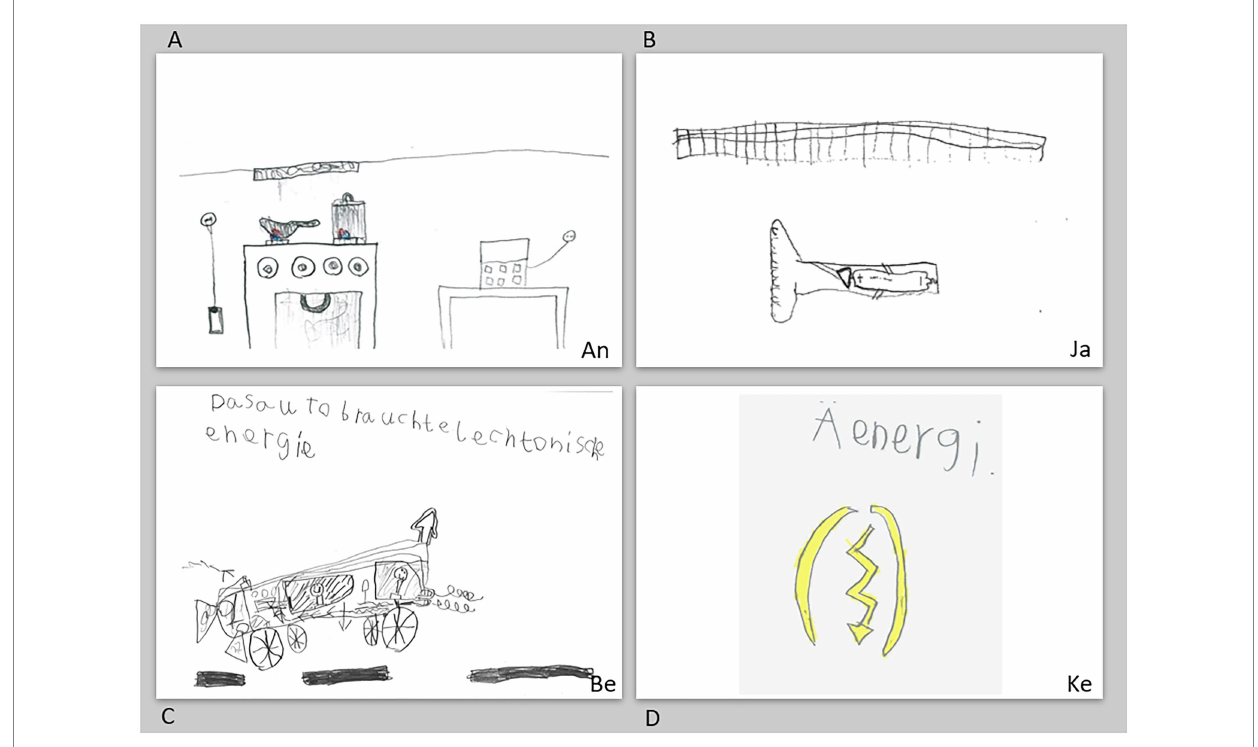
FIGURE 3 Four drawings/notes of associations with energy that (partly) refer to electric devices or electricity. A & B : drawing only, C & D : drawing and